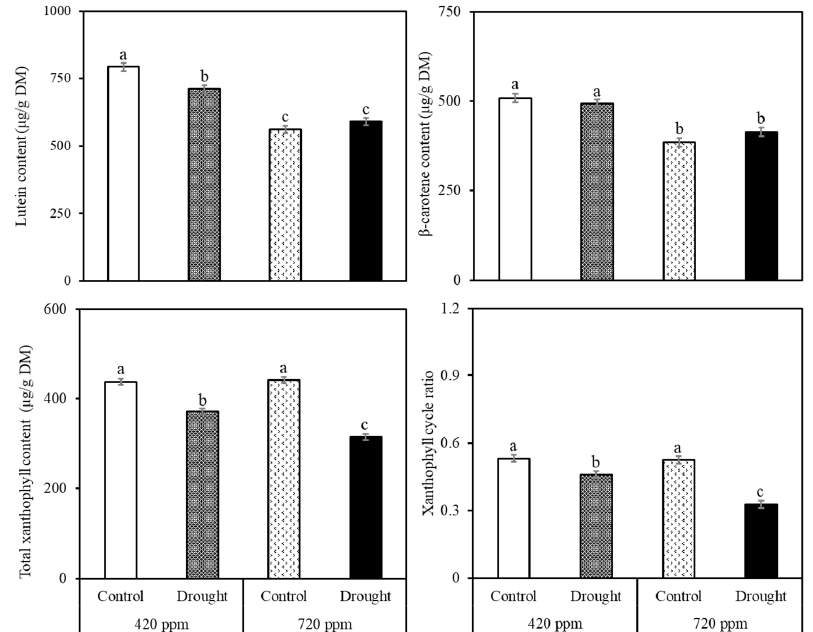
Figure 2. Lutein (Lut), β -carotene ( β -car), Total xanthophyll, and Xanthophyll cycle ratio (Za/Zav) estimation of basil plants grown without drought stress (control) and with drought stress at two levels of CO 2 (420 and 720 ppm) after 17 days of treatment. Data are presented as treatment means ± SE ( n = 10). Different low case letters indicate a significant difference at p < 0.05 by the least significant difference. DM, Dry mass.